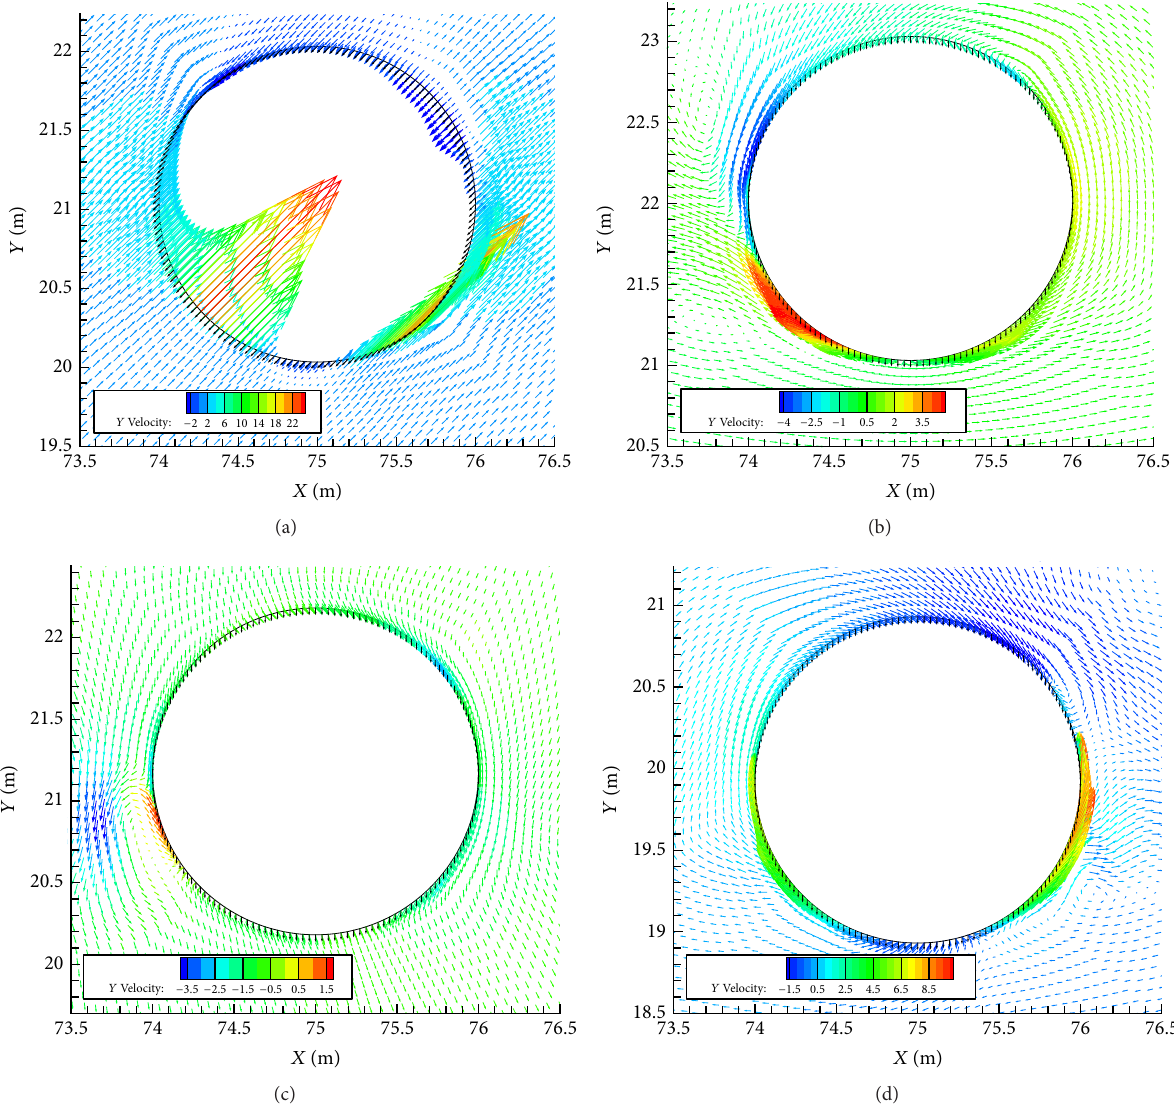
Figure 11: Velocity vectors when water impact occurs with different impact phase angles: (a) 0 ∘ ; (b) 90 ∘ ; (c) 180 ∘ ; (d) 270 ∘ .